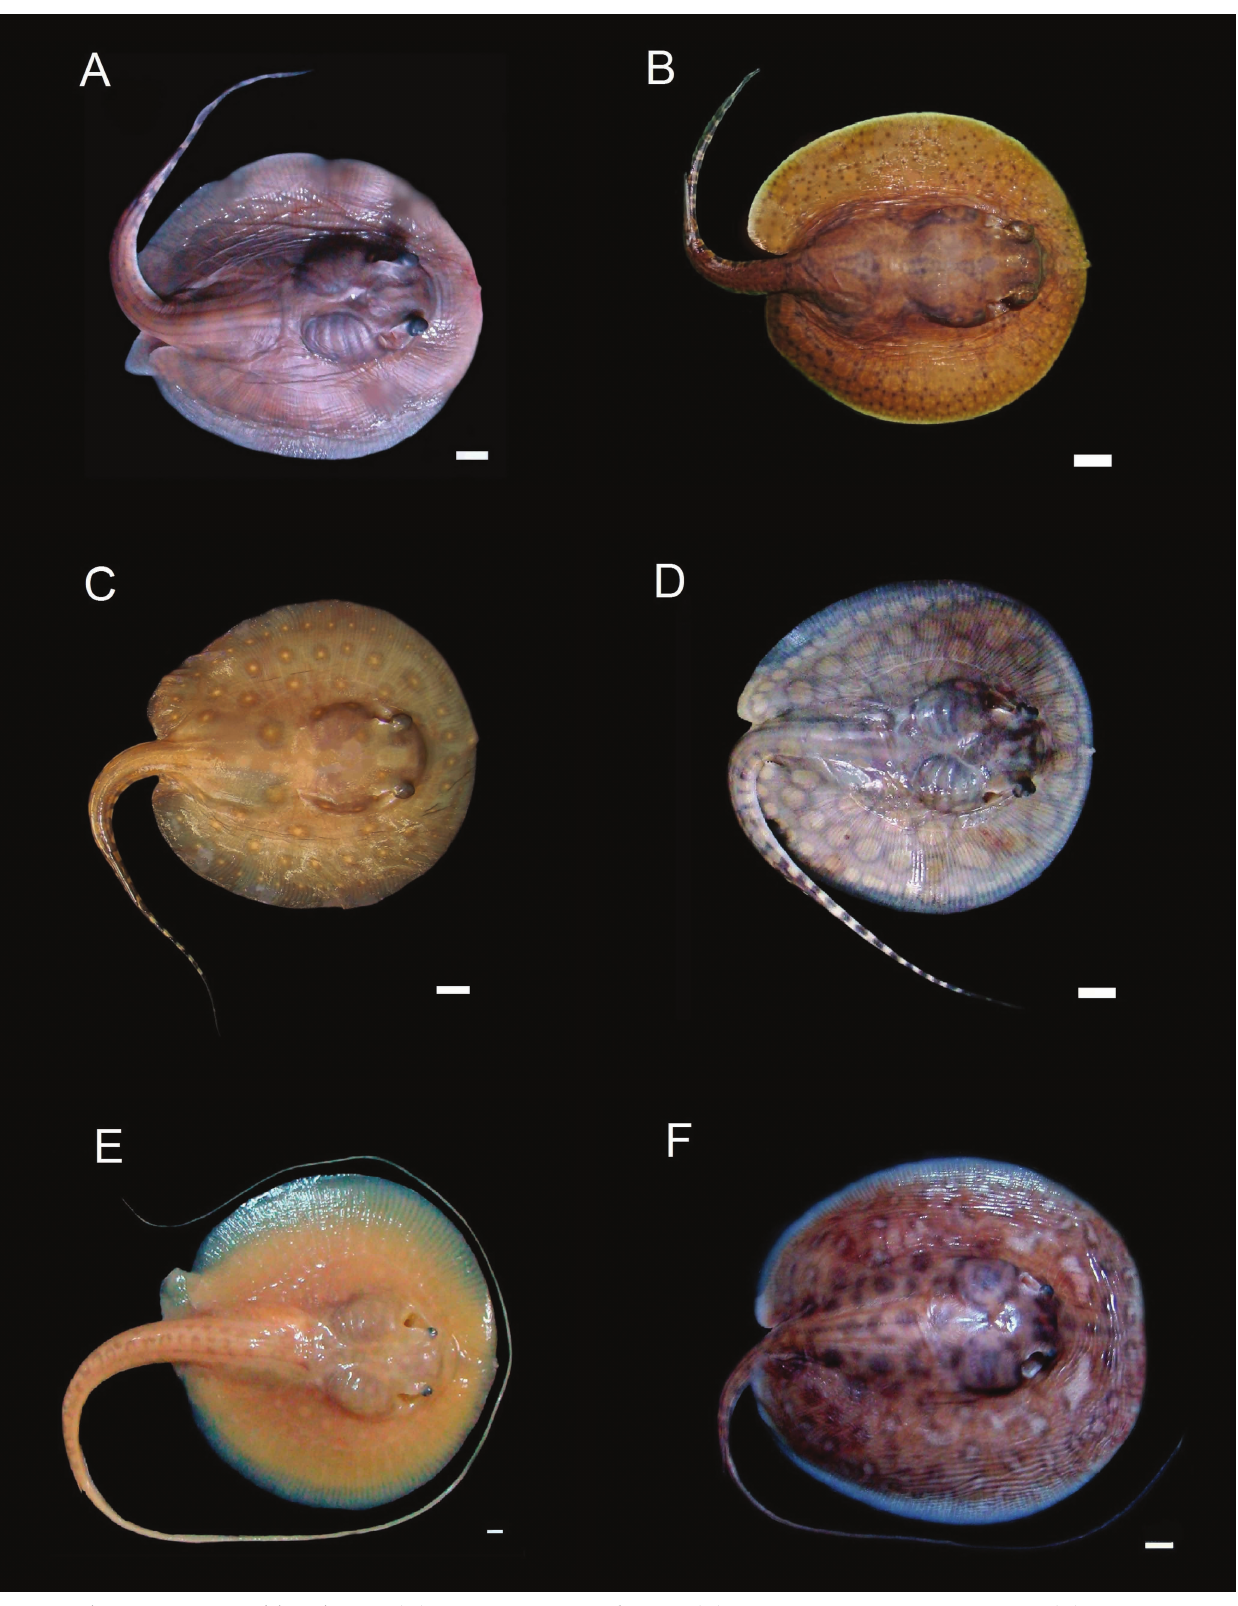
Fig. 1 . The potamotrygonid embryos: (A) Potamotrygon orbignyi ; (B) cururu ray Potamotrygon sp.; (C) Potamotrygon motoro (from Negro River); (D) Potamotrygon motoro (from Solimões River); (E) Plesiotrygon iwamae ; (F) Paratrygon aiereba. Scale bars= 1